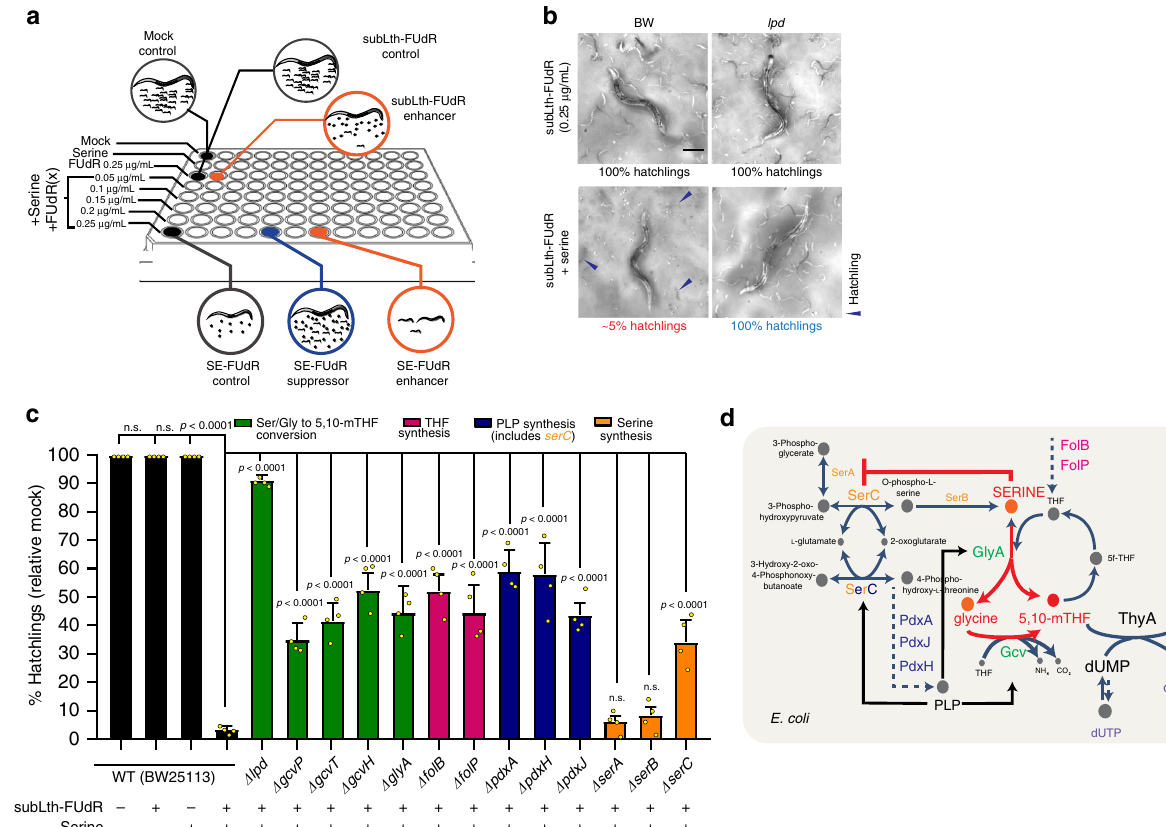
Fig. 3 SE-FUdR toxicity requires E. coli ’ s folate and pyridoxal phosphate synthesis pathways. Throughout this fi gure: statistical signi fi cance was assessed via two-tailed unpaired nonparametric t -test for % hatchlings quanti fi cation. Data are presented as mean values ± SEM, scale bars = 200 µ m, n = # independent biological replicates. Source data are provided as a Source Data fi le. a Setup of four-way E. coli KO screen for mediators of serine- enhanced FUdR toxicity. Screening was carried out in the BW25113 background in triplicate at 25 °C in 8 conditions: (1) mock, (2) serine 1.5 mg/mL, (3) subLth-FUdR 0.25 µ g/mL, and (4 – 8) serine 1.5 mg/mL plus subLth-FUdR from 0.05 to 0.25 µ g/mL (lower doses included to detect toxicity enhancers). Each column of the 96-well plate corresponds to a different E. coli KO. Developmental stage and progeny viability were scored. b Representative images of validation of the toxicity-suppressor effect of knocking down E. coli lpd , making evident that SE-FUdR toxicity is bacterially driven. n = 4. c Effect of the E. coli suppressors of SE-FUdR toxicity on progeny viability (% hatchlings). Images and data were analyzed as described in Fig. 1. n = 4. d Working model of how dietary serine promotes synthesis of 5,10-mTHF in E. coli . Color codes of suppressor gene names are consistent with c . Serine relevant actions (depicted in red): (1) inhibits its own synthesis releasing serC to promote PLP synthesis (PLP is an essential cofactor for GlyA and the GCV complex); and (2) serves